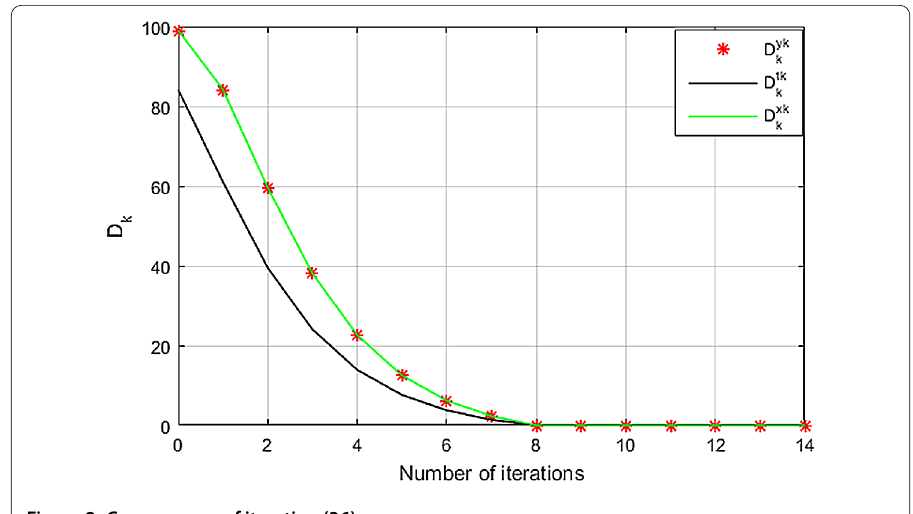
Figure 2 Convergence of iteration (36).